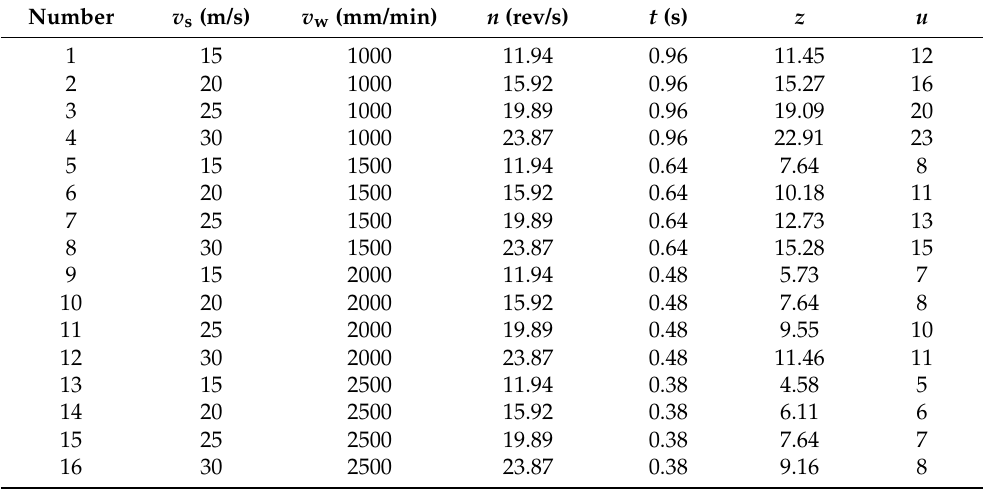
Table 4. Comparison between the number of wheel runouts and the number of peaks in force signals.